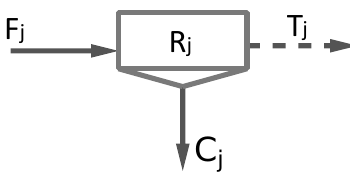
Figure 1. The mass conservation component j in a single unit.